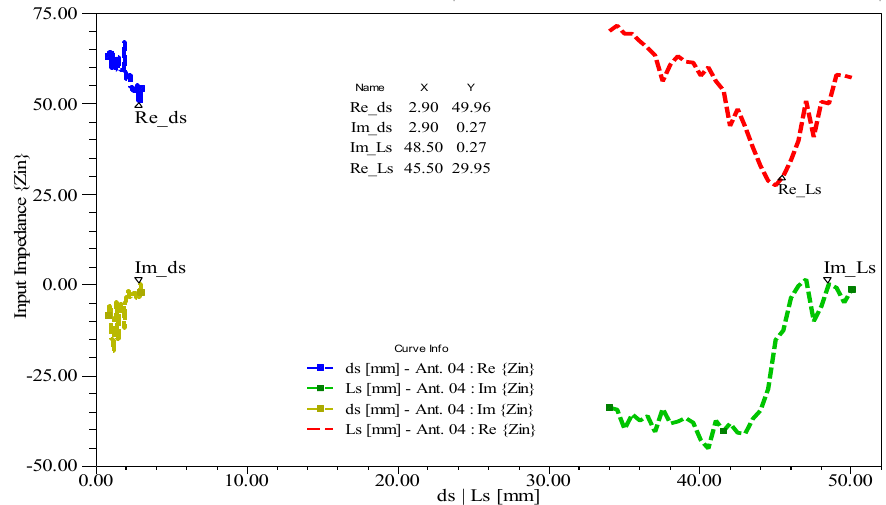
Figure 16. Input impedance of Slot antenna 4 at 2450 MHz versus ds and Ls (mm).